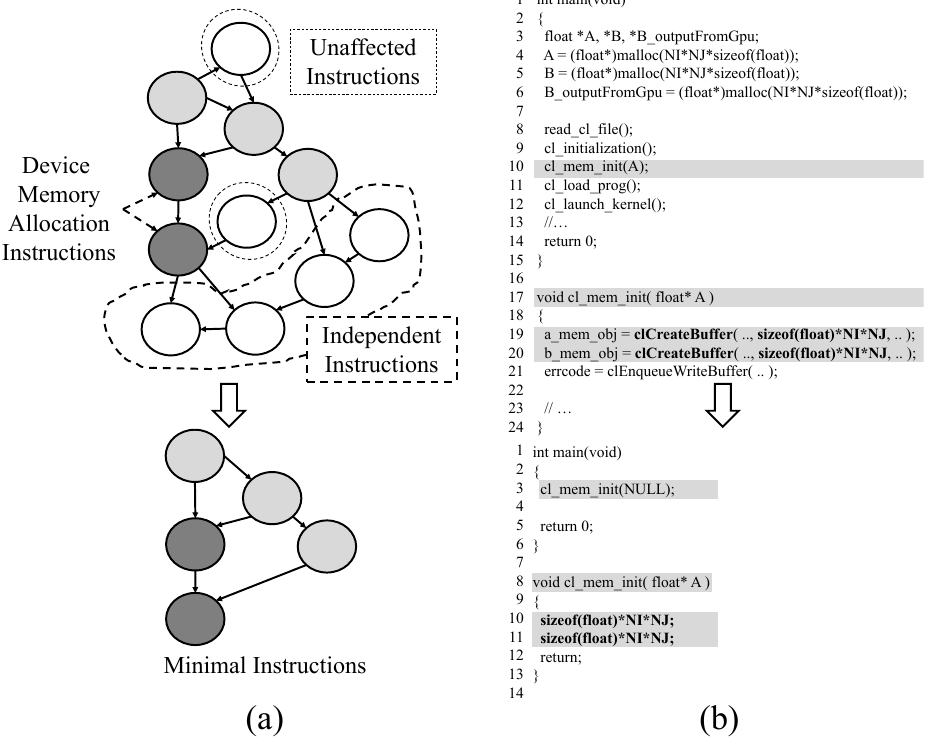
Figure 7. Extracting minimal instructions for memory requirement estimation. ( a ) Overview and ( b ) a translation